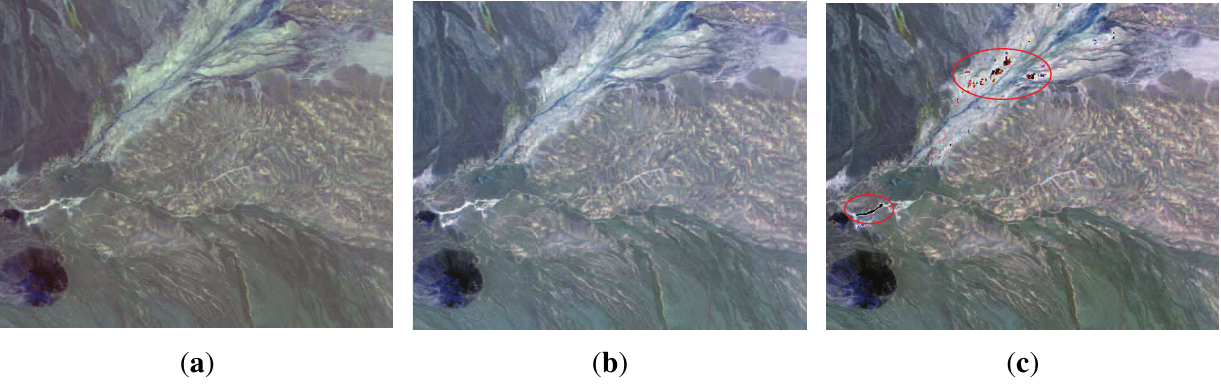
Figure 7. Comparison of color display results obtained by our PDADVS model with: ( a ) ξ = 0 ; ( b ) ξ = 0 . 5 ; and ( c ) ξ = 5 on the subimage (3161 : 3672 , 21 : 634) extracted from the AVIRIS image Lun.lake _ igm . The “pop out” areas are denoted by red ellipsoids in the Figure 7c. Table 5. ρ and δ scores obtained by the PDADVS model for increasing values of λ